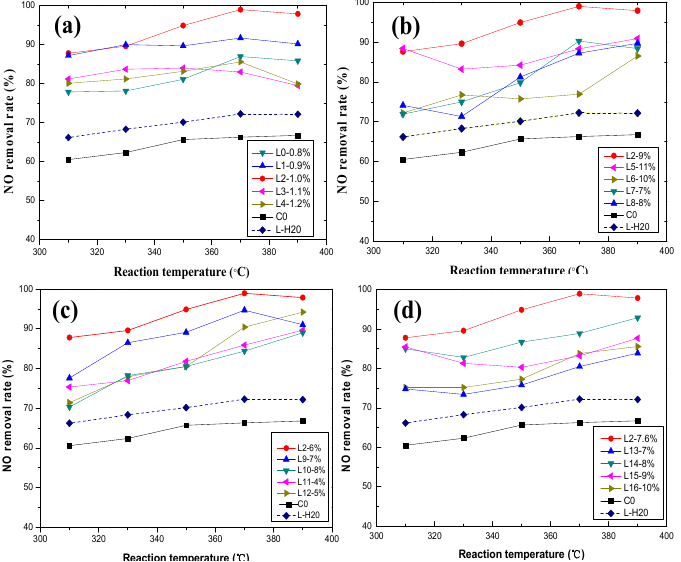
Figure 3. Effect of active ingredients on NO removal rate: ( a ) vanadium; ( b ) tungsten; ( c ) molybdenum; and ( d ) oxalic acid.